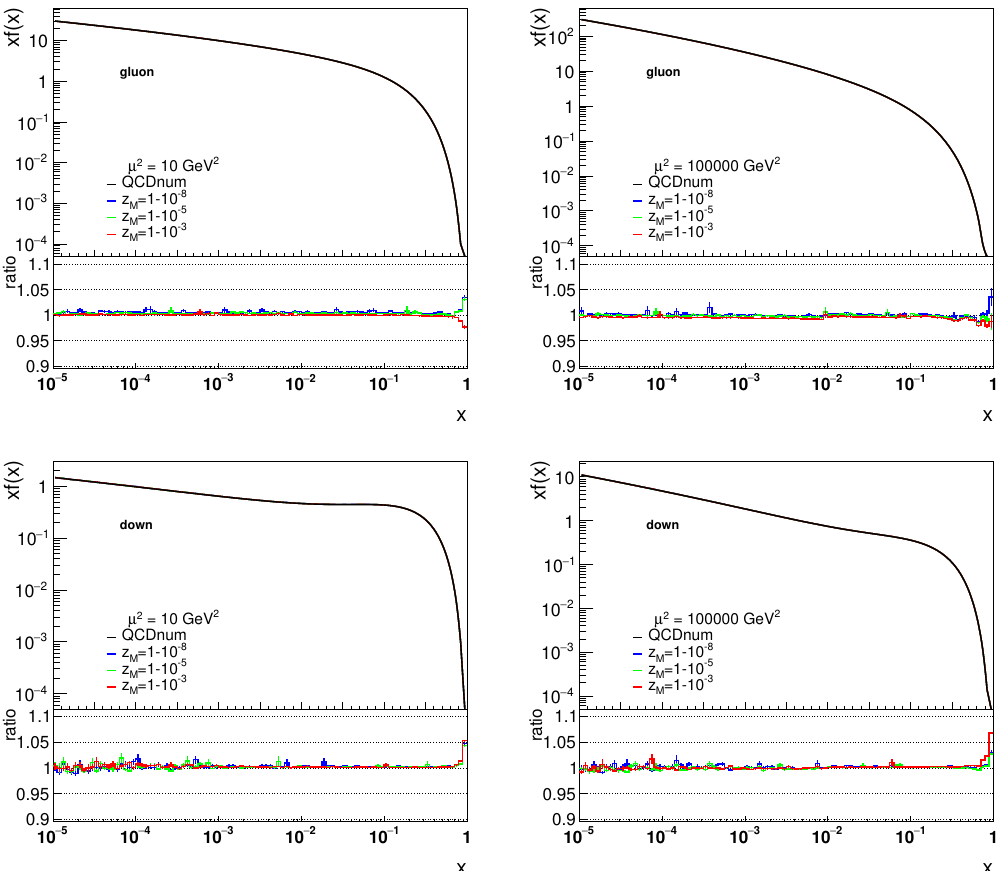
Figure 4 . The transverse momentum integrated (iTMD) parton densities obtained from the parton branching solution, compared with the prediction from Qcdnum . The densities are evolved up to di(cid:11)erent scales (cid:22) 2 using splitting kernels at NLO, for di(cid:11)erent values of z M . The ratio plots show the ratio of the curves obtained with the parton branching method divided by the prediction from Qcdnum